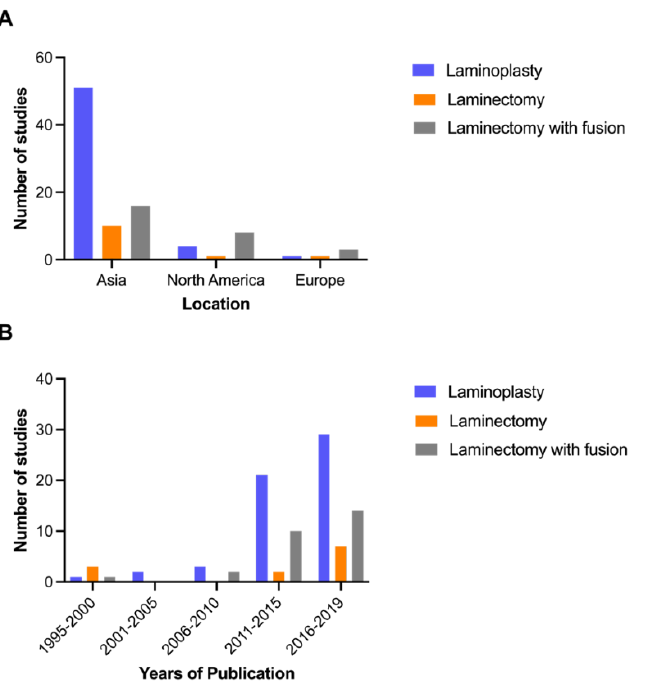
Figure 2. Location ( A ) and trend ( B ) of published research. Table 1. Study